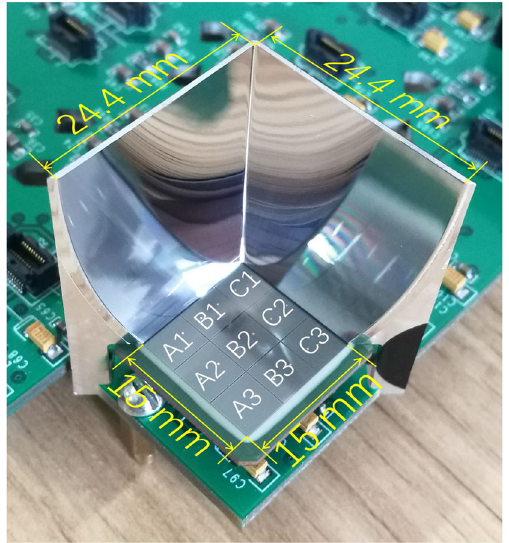
Fig. 7 A half-funnel mounted on a SiPM. The marks A1 to C3 are the channel naming convention for the 3 × 3 channels array of the SiPM